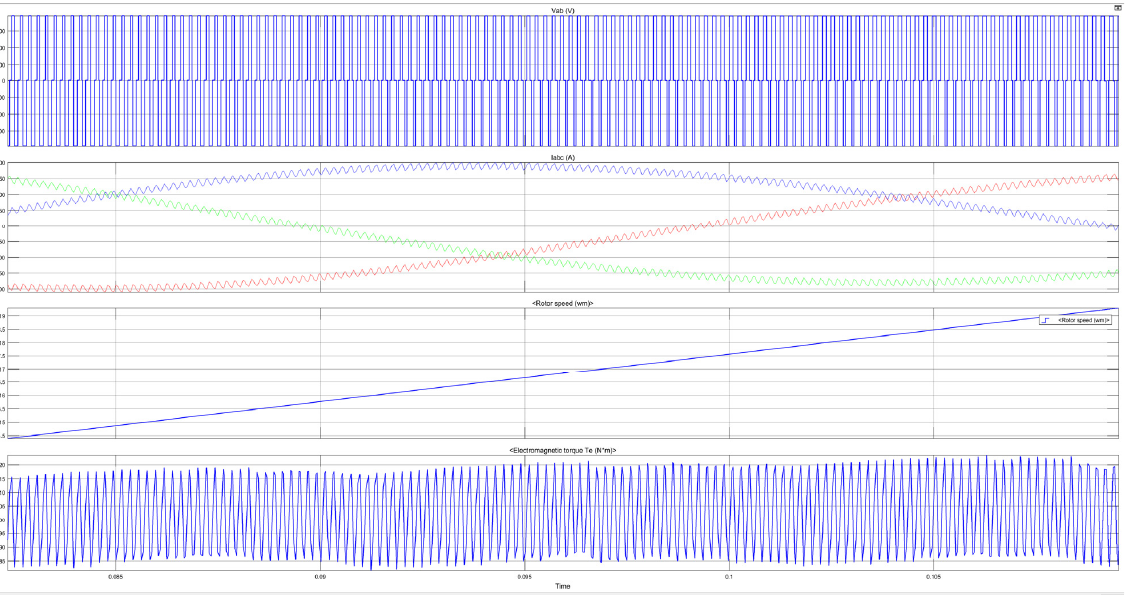
Figure 1. Diagrams of voltage changes between two phases, electric current in three phases, angular speed of motor and torque.